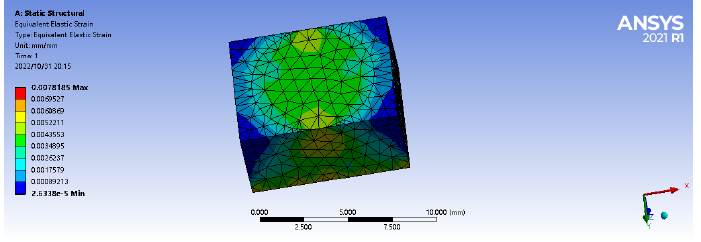
Figure 3. Elastomer simulation model.